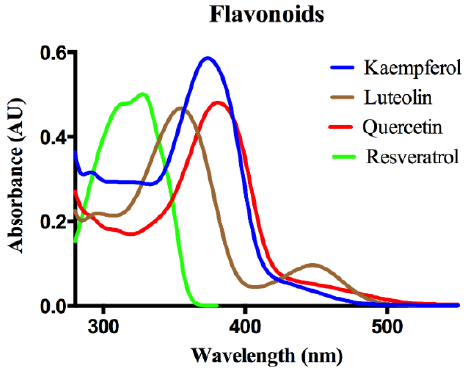
Figure 2. UV-Visible spectral signatures of tested flavonoids in methanol.